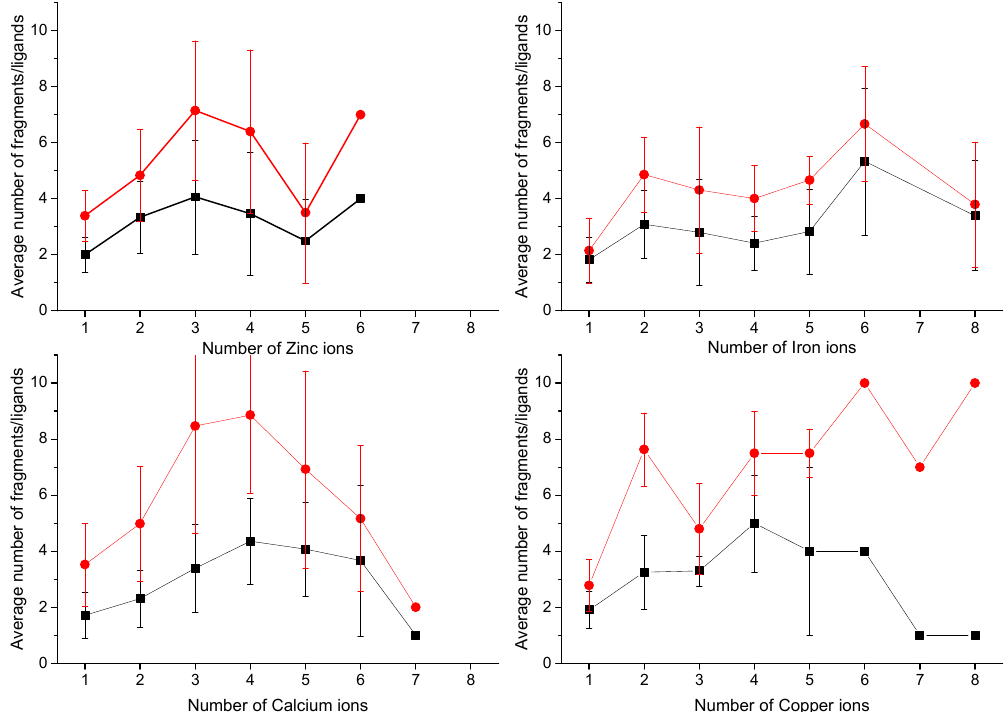
Figure 2. Average number of fragments (black lines and squares) and amino acid ligands (red lines and circles) as a function of MFS nuclearity for different metals. Only fragments containing at least one amino acid ligand to the metal ion(s) were counted. The statistics includes all MFS sites with a minimum number of donor atoms for each metal (three for zinc, four for iron and calcium, two for copper). This eliminates a significant part of adventitious sites at the protein surface. The data